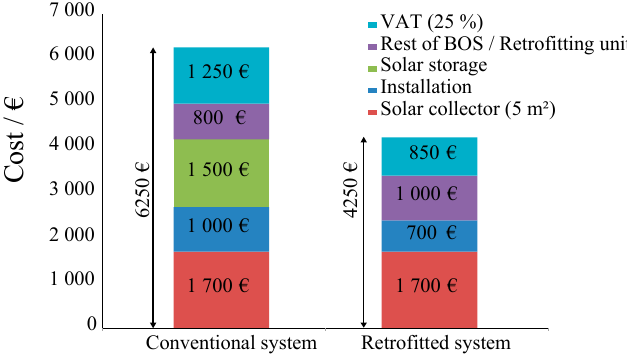
Figure 6. Costs of the different parts of the conventional and retrofitted solar domestic hot water systems, including VAT.